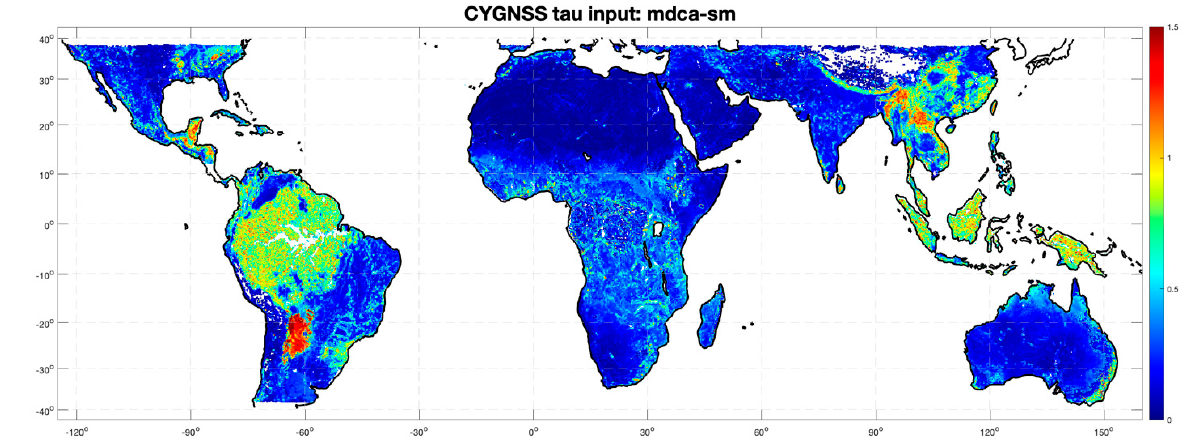
Figure 7. Example of CYGNSS-derived VOD by Xu et al.